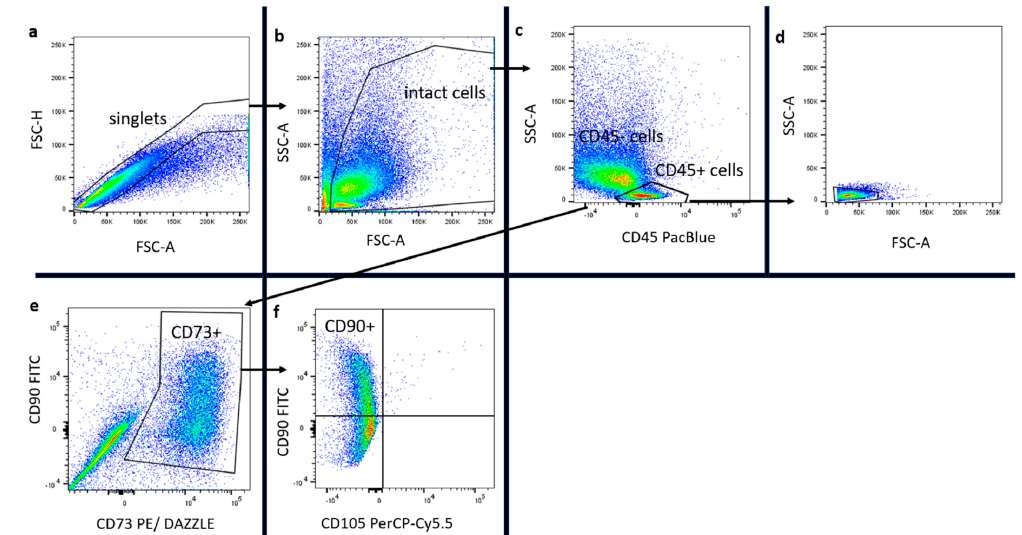
Figure 3. Part I of the gating strategy applied in the study, shown here with PLA cells of one patient. In ( a ), singlets were gated. In ( b ) of all singlets, intact cells were gated, leaving cell fragments aside. In ( c ) of all intact cells, CD45 + cells were gated. In ( d ), CD45+ cells are shown in SSC/FSC. In ( e ), the CD45- cell population was assessed for CD73 expression. In ( f ), these CD45-, CD73+ cells were assessed for CD105 and CD90 expression. Stem cells appear to be CD45-, CD73+, CD90+, and CD105-.